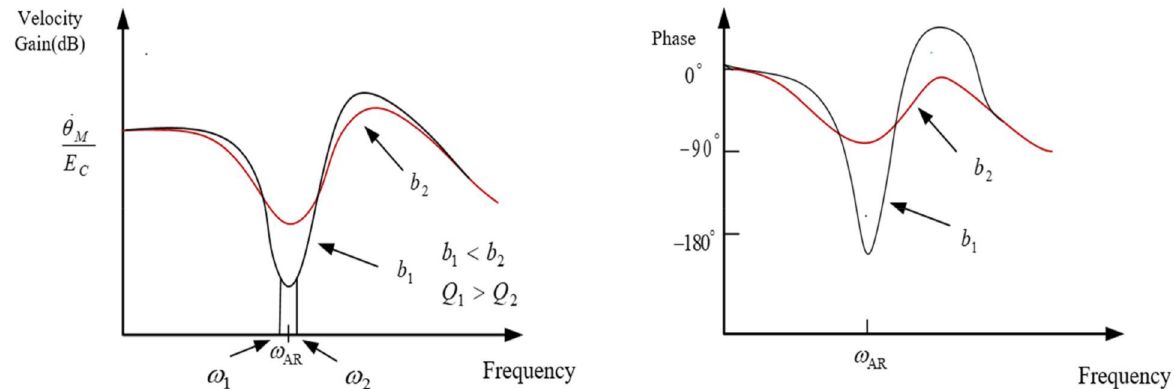
Figure 6. Influence of viscous damper coefficient b on anti-resonance peak